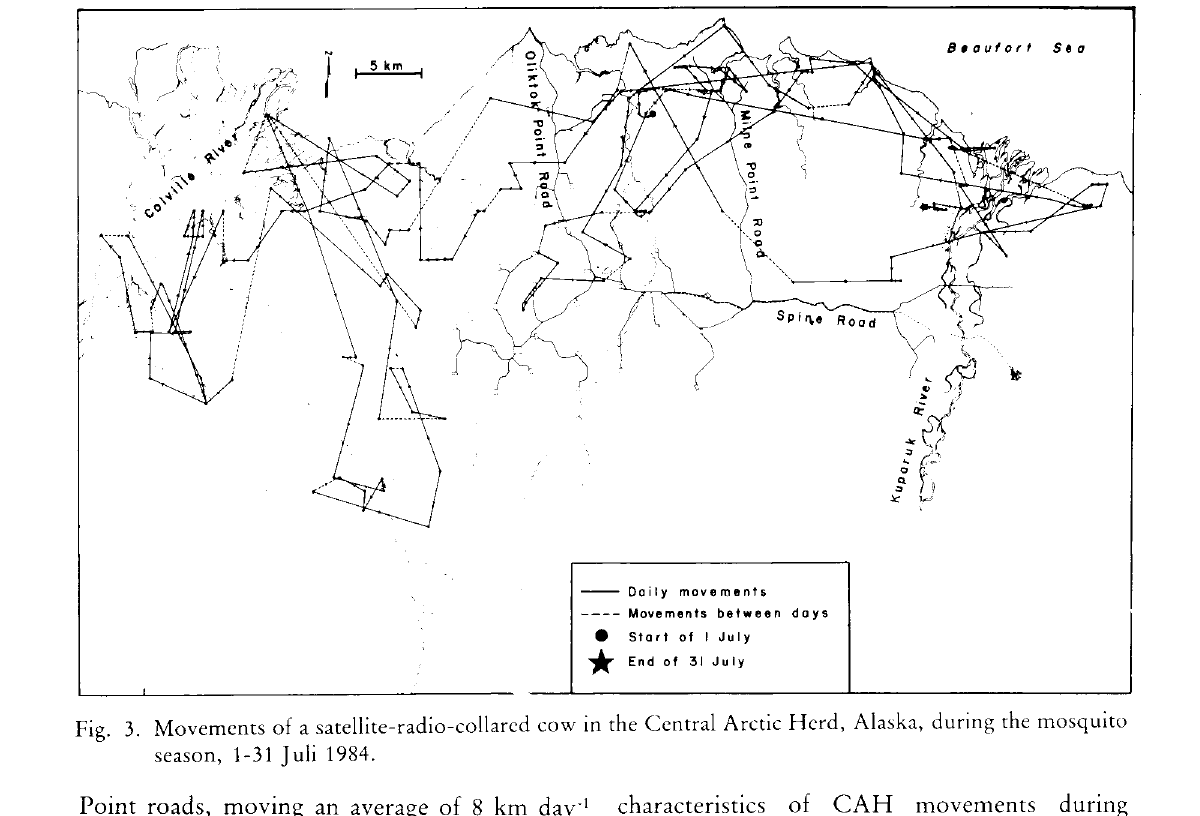
Fig. 3. Movements of a satellite-radio-collared cow in the Central Arctic Herd, Alaska, during the mosquito season, 1-31 Juli 1984. Point roads, moving an average of 8 km day